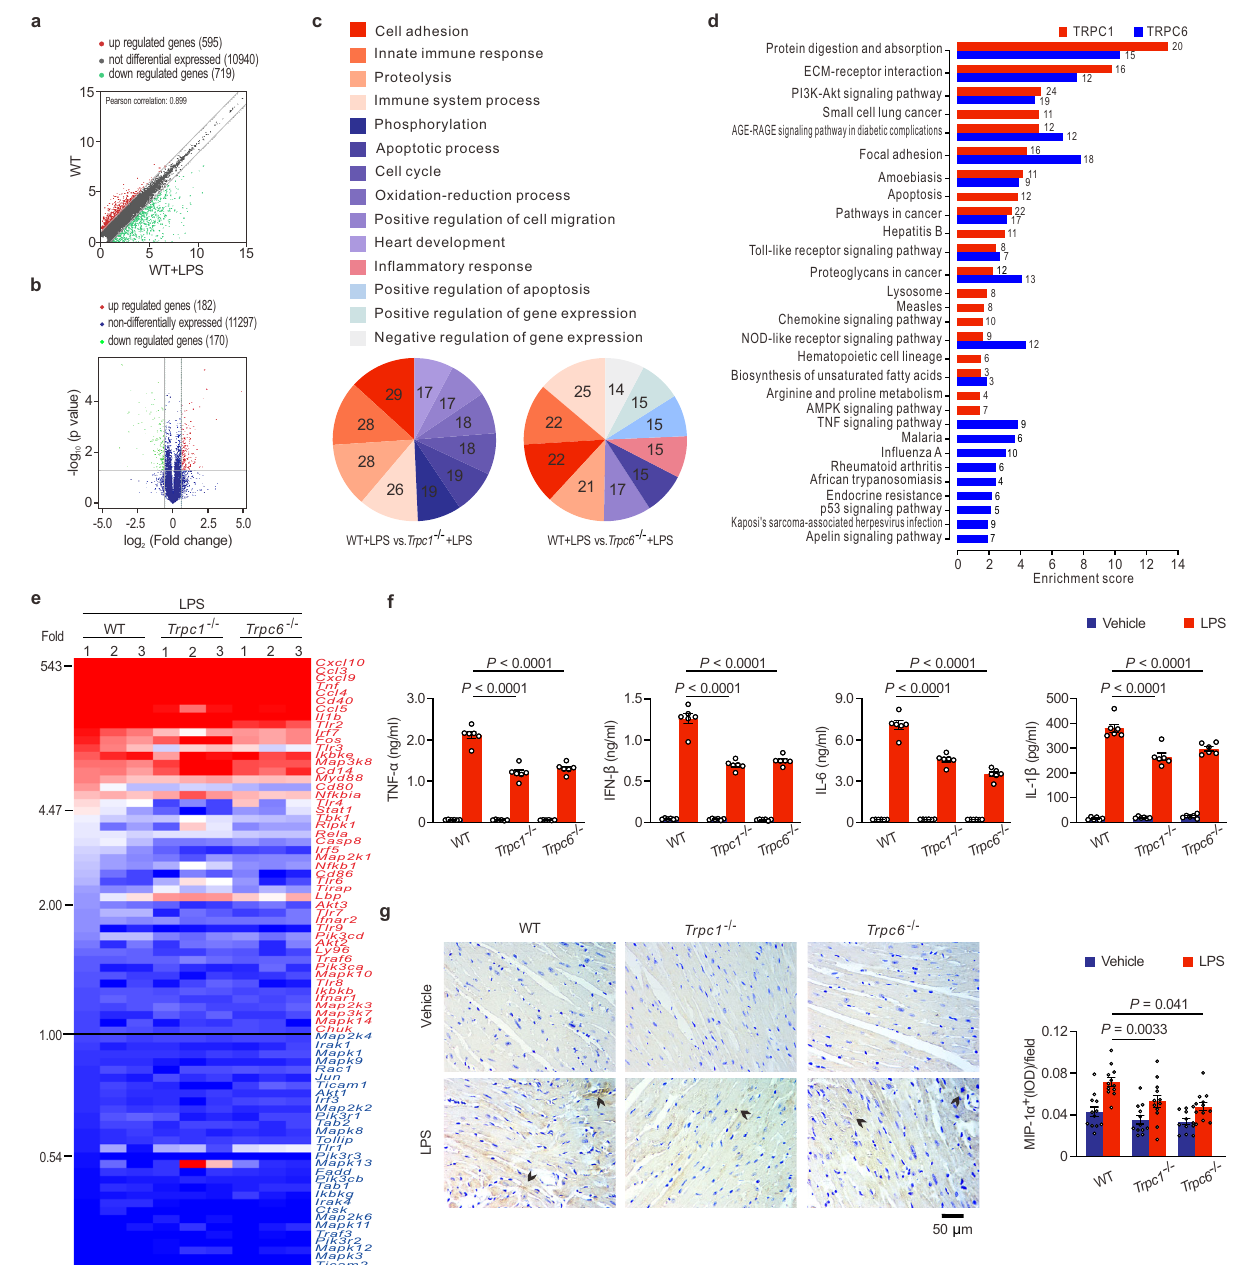
Fig.2|The Trpc1 or Trpc6 knockoutinhibitsTLRsignalingpathway.a Pearson ’ s correlation test of all the detected genes of RNA-seq in the LPS-challenged mice compared to control. b Volcano plot of the changed genes in RNA-seq between Trpc1 − / − and Trpc6 − / − mice after LPS challenge. c Counting pie charts depicting the top-ranked biological process classi fi cation of the differentially expressed genes in RNA-seq using Gene Ontology terms. d The top 20 down-regulated pathways in the Kyoto Encyclopedia of Genes and Genomes (KEGG) database of LPS-challenged Trpc1 − / − or Trpc6 − / − micecomparedtotheWTmice. e Theheatmapofthegenesinthe TLR signaling pathway from the KEGG database based on RNA-seq analysis. The valuesfromRNA-seqin a – e areobtainedfrom3malemicepergroup. f Serumlevels of TNF- α , IFN- β , IL-6, and IL-1 β in mice 6h after LPS challenge (mean±SEM, n =6